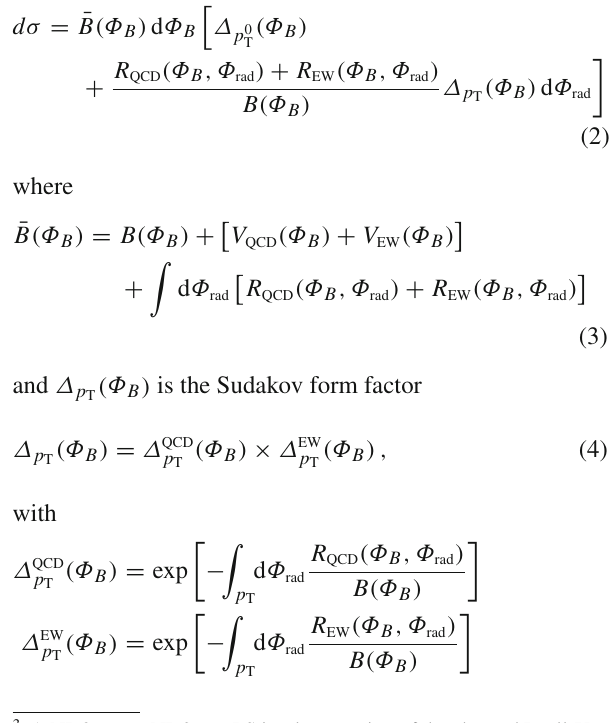
It has been used in Ref. [69] to simulate the process pp → ¯ (cid:4)ν ¯ ν ¯ b b (cid:4) with NLO QCD +PS accuracy, thereby achieving,